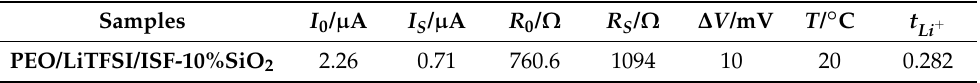
Table 4. The lithium-ion transference number ( t